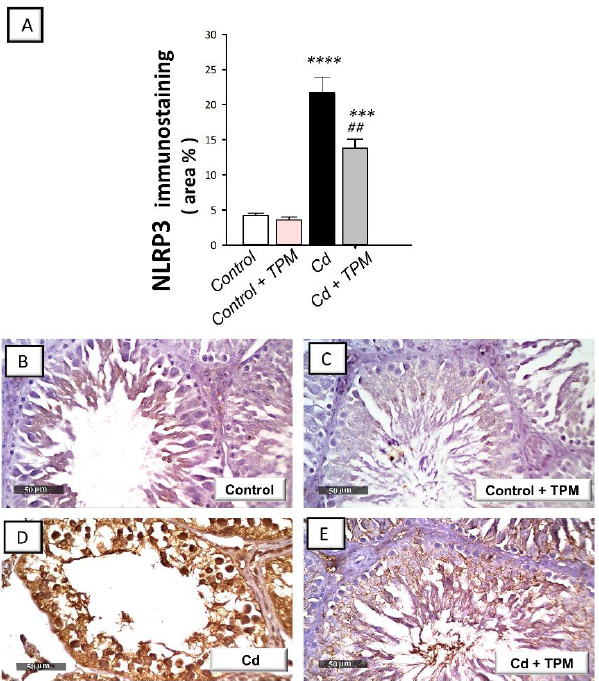
Figure 3. Effect of cadmium and/or topiramate on NLRP3 protein expression in testes of rats. The co-treatment with topiramate lowered the testicular protein expression of NLRP3 which was increased by cadmium administration. The determination of NLRP3 protein expression was carried out by detection of its immunostaining (brown color) in testes of animals at 400× magnification. The slides were counterstained with hematoxylin. ( A ) Quantitative analysis of NLRP3 immunostaining where topiramate lowered the immunostaining of NLRP3 [H (3, 20) = 43.31, p < 0.0001]. The quantification was presented as the area % of the brown immunostaining relative to the microscopic field’s whole area (in each section, six non-overlapping fields were investigated). Results are demonstrated as the mean ± standard error of the mean (SEM). *** p < 0.001, or **** p < 0.0001 signifies statistical significance versus the control group; ## p < 0.01 signifies statistical significance versus cadmium chloride-treated group. ( B , C ) Representative photomicrographs showing minimal expression in the control and topiramate-treated control groups, respectively. ( D ) Representative photomicrographs showing increased immunostaining of NLRP3 in cadmium-intoxicated group. ( E ) Representative photomicrographs showing that topiramate downregulated the protein expression of NLRP3 as indicated by lowered immunostaining. NLRP3, the nucleotide-binding domain (NOD)-like receptor family, pyrin domain-containing 3. TPM, topiramate; Cd, cadmium